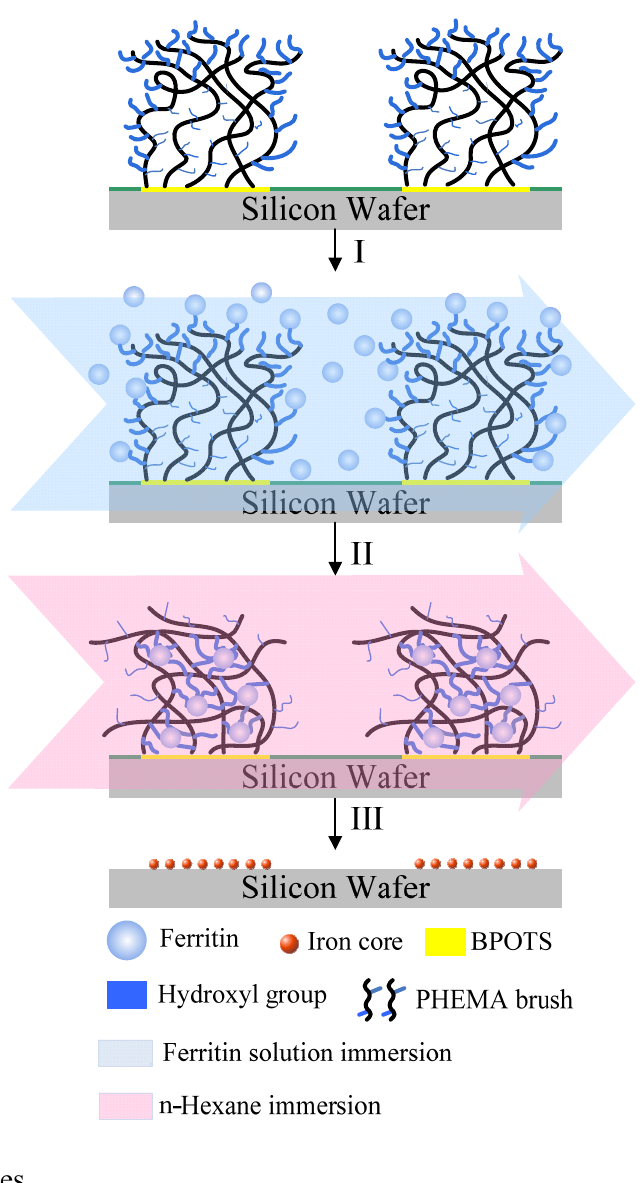
Figure 16. Schematic representation of the strategy for ferritin capture. ( I ) The sample surface presenting the patterned PHEMA brushes is immersed for 1 h into a mixture of water and MeOH containing dispersed ferritin; ( II ) The sample surface is immersed into n-hexane to transform it from a brush-like to a mushroom-like structure, with the OH groups of the PHEMA brushes becoming buried within the PHEMA thin film to form hydrophilic domains; ( III ) The ferritin species on the PHEMA thin film surface are removed through degradation of the protein sheath under O in an oven at ca. 500 °C to observe the 2 ferrihydrite cores. Reprinted from Reference [204] with